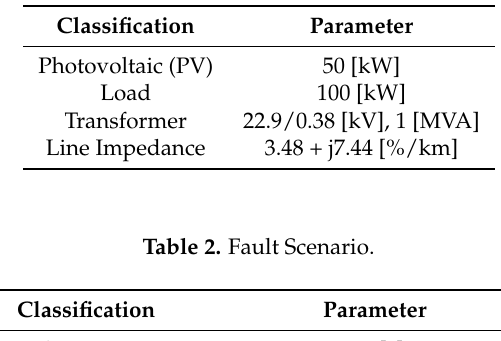
Table 1. Parameters of LVDC system .